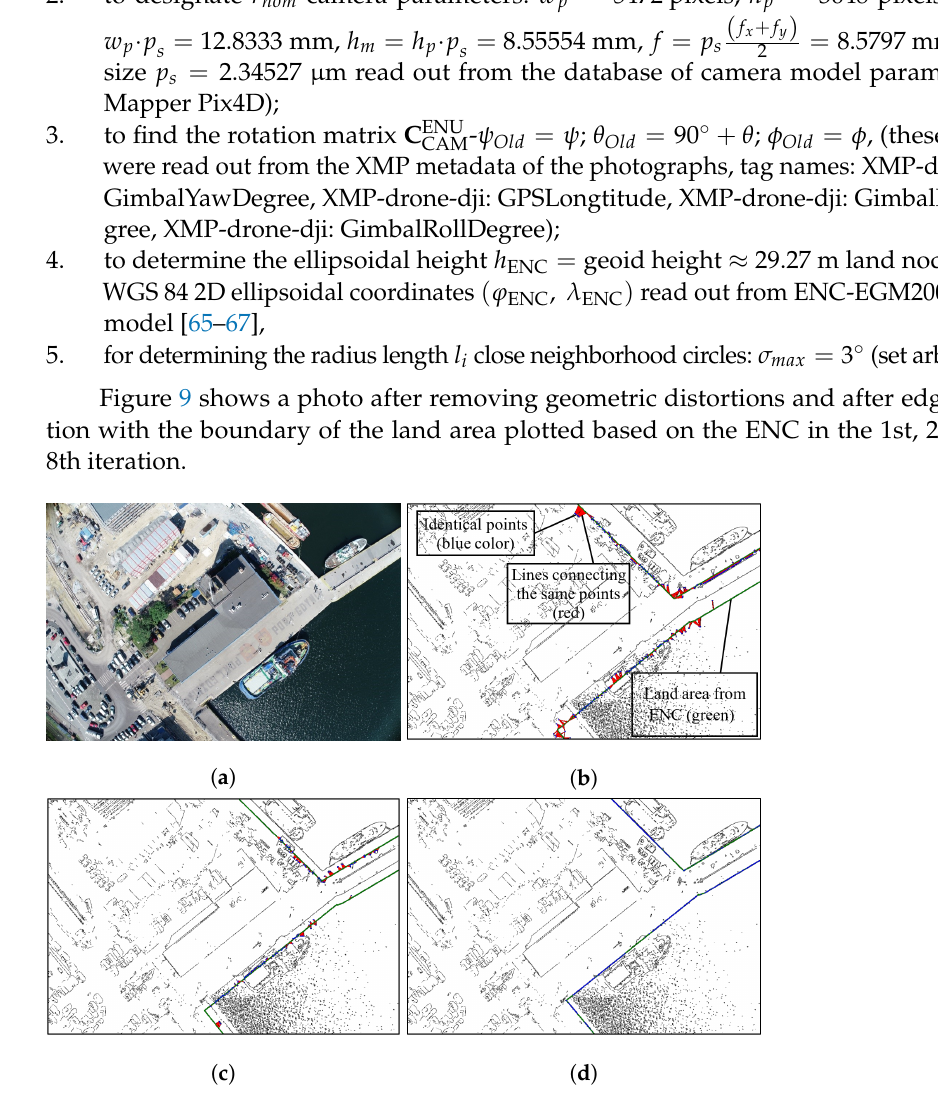
Figure 9. The process of matching the land area lines generated from the ENC to the edges detected in the image: ( a ) Source image; ( b ) Step 1 of iteration, l 1 = 115 pixels, σ 1 = 3 ◦ ; ( c ) Step 2 of iteration, l 2 = 58 pixels, σ 2 = 1.5 ◦ ; ( d ) Step 8 of iteration, l 8 = 1 pixel, σ 8 = 0.023 ◦